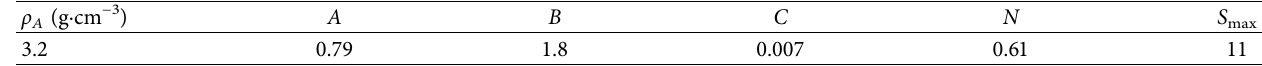
Table 3: Mechanical parameters for the abrasives.